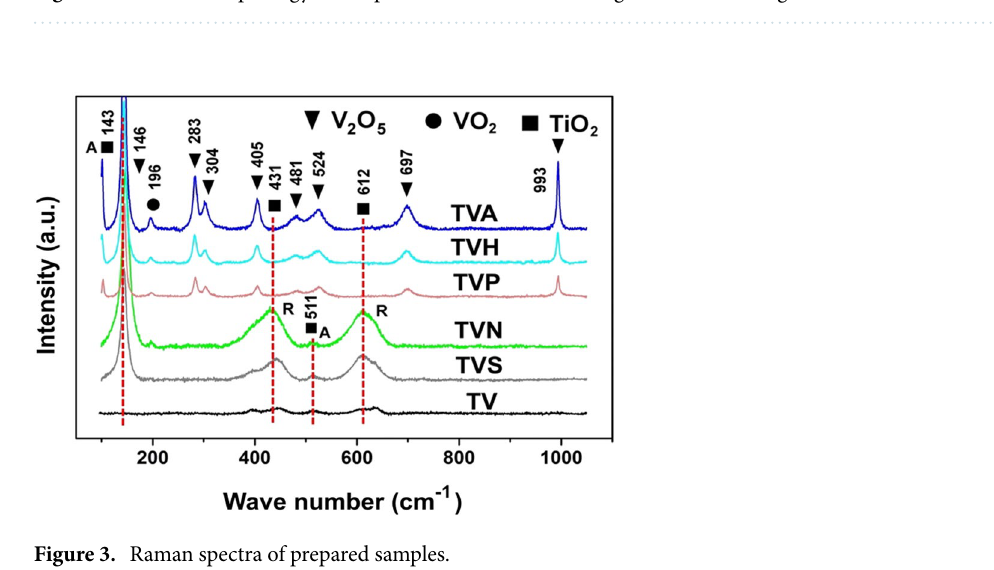
Figure 2. Surface morphology of samples located in different magnetic fluxes arrangements.